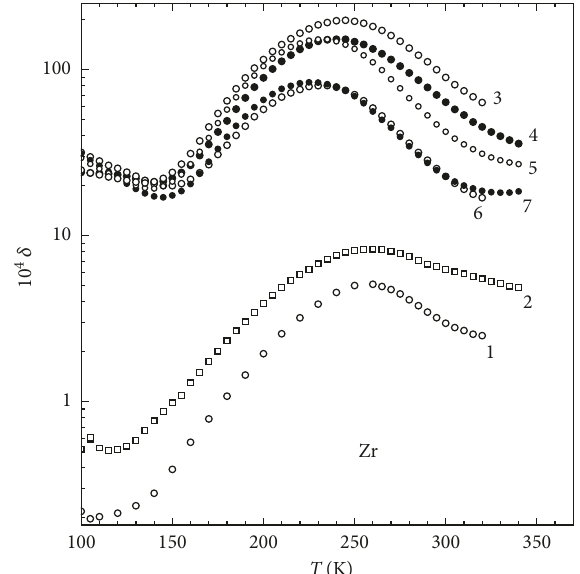
Figure 1: Temperature dependences of the logarithmic decrement in zirconium samples with the different mean grain size d : 1-Zr-CG, d 150 μ m; 2-Zr-HEA, d (cid:29) d 392nm; 5-Zr-01, d (cid:29)